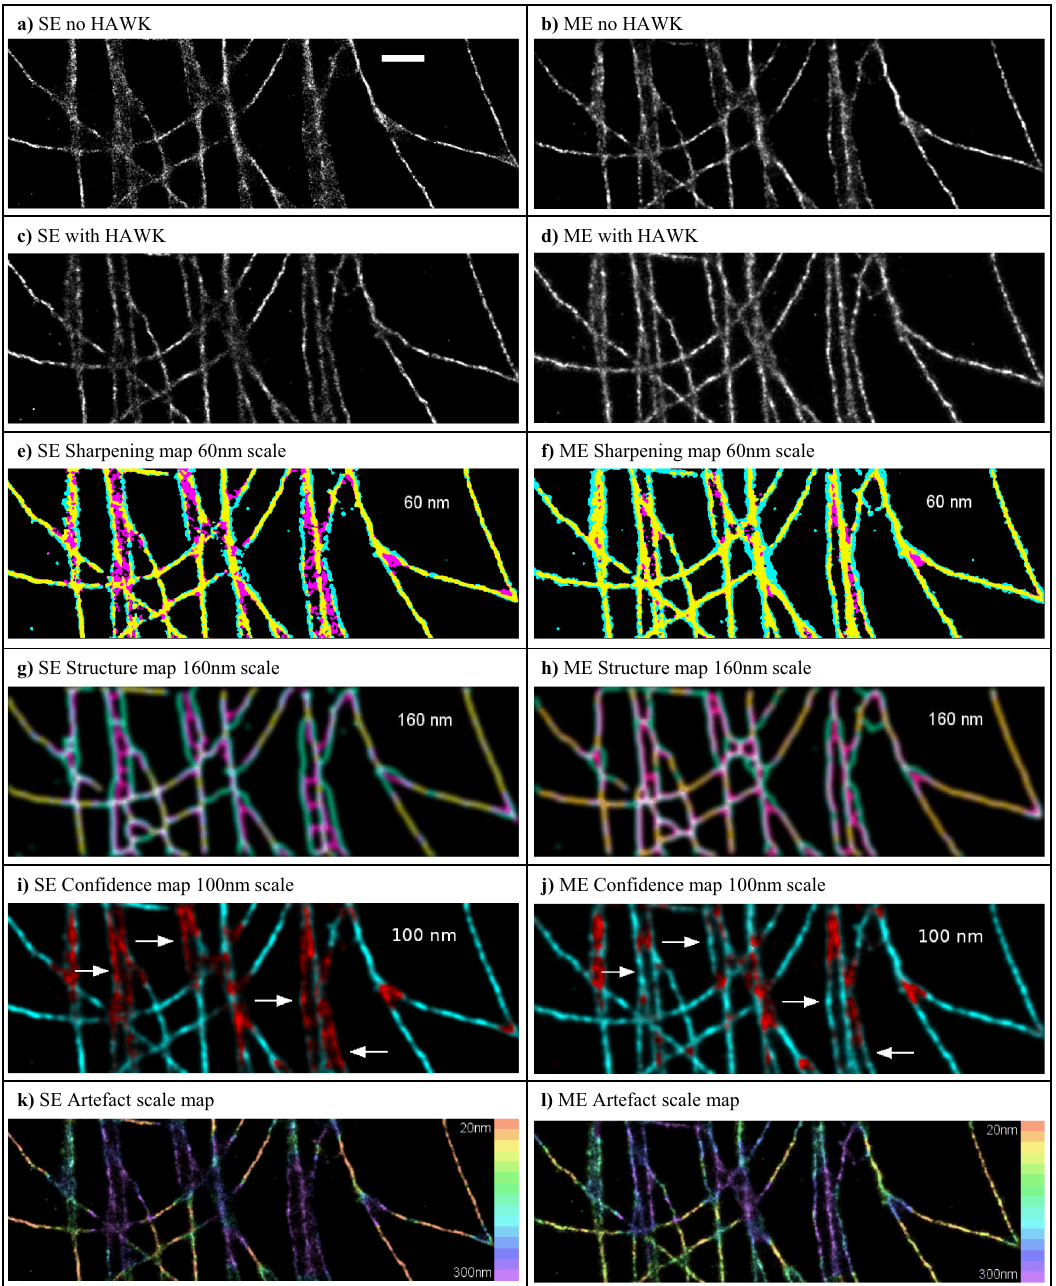
Fig. 3 Results of HAWKMAN analysis on experimental microtubule data from the Localisation Microscopy Challenge comparing SE and ME fi tting. The reconstructions for SE and ME fi tting without HAWK are shown in a and b , respectively along with their equivalents c and d when HAWK is used. The results of HAWKMAN analysis are shown in the sharpening maps ( e , f ), the structure maps ( g , h ) and the con fi dence maps ( i , j ) for selected length scales. The SE reconstruction ( a ) shows substantial density-induced sharpening artefacts. The differences in structure between this reconstruction and the results of applying HAWK with SE fi tting are highlighted by the sharpening map ( e ) shown at an example scale of 3 reconstruction pixels (60 nm using 20 nm size pixels). Substantial bias in the SE reconstruction where microtubules are in close proximity/crossing is highlighted in the structure map ( g ) even at a scale of 160 nm. Reliable regions in the reconstruction where both methods agree are highlighted in the con fi dence map ( i ), shown at the 100 nm scale. ME fi tting ( b ) gives a more accurate reconstruction, however, as can be seen in ( f , h , j ) it still contains numerous artefacts. The con fi dence map (100 nm scale) ( j ) for this reconstruction shows a reduction in the severity of artefacts but some remain. The white arrows highlight some of the structure accurately reported (at this length scale) in the ME result ( j ) that were inaccurate in the SE case ( i ). A summary of the HAWKMAN results at all length scales is shown in the artefact scale maps ( k , l ) which indicate the maximum scale of artefacts at each area of the sample (colour indicates length scale in pixels (20 – 300 nm). Comparison of the SE ( k ) and ME ( l ) results shows that for ME fi tting the maximum scale of artefacts is reduced in areas of high microtubule density. Scale bar 1 µ